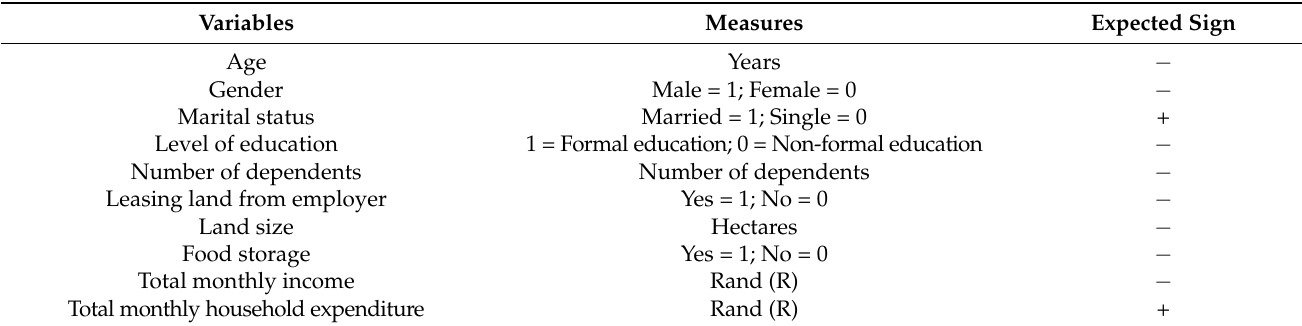
Table 1. Description of independent variables used in the